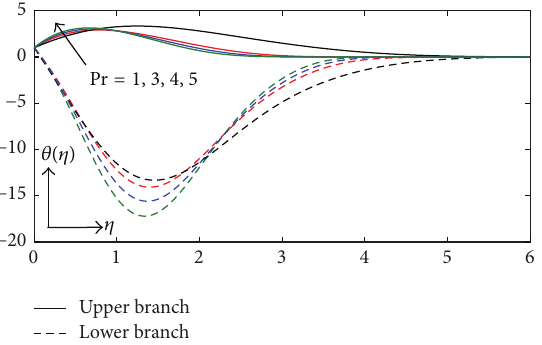
Figure 14: Temperature profiles for various values of Pr with 𝑠 = −3 , 𝛾 = 1 , 𝜆 = 0.5 , and 𝑀 = 0.2